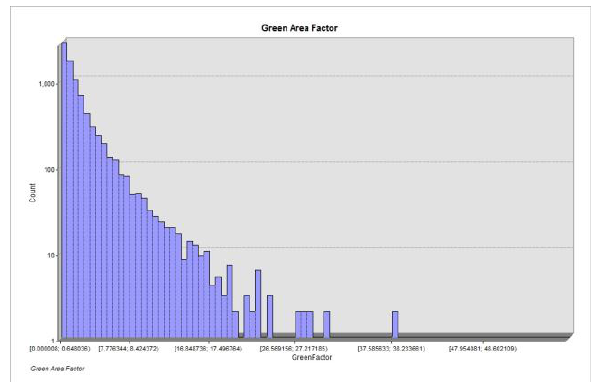
Figure 8 Road surface Factors